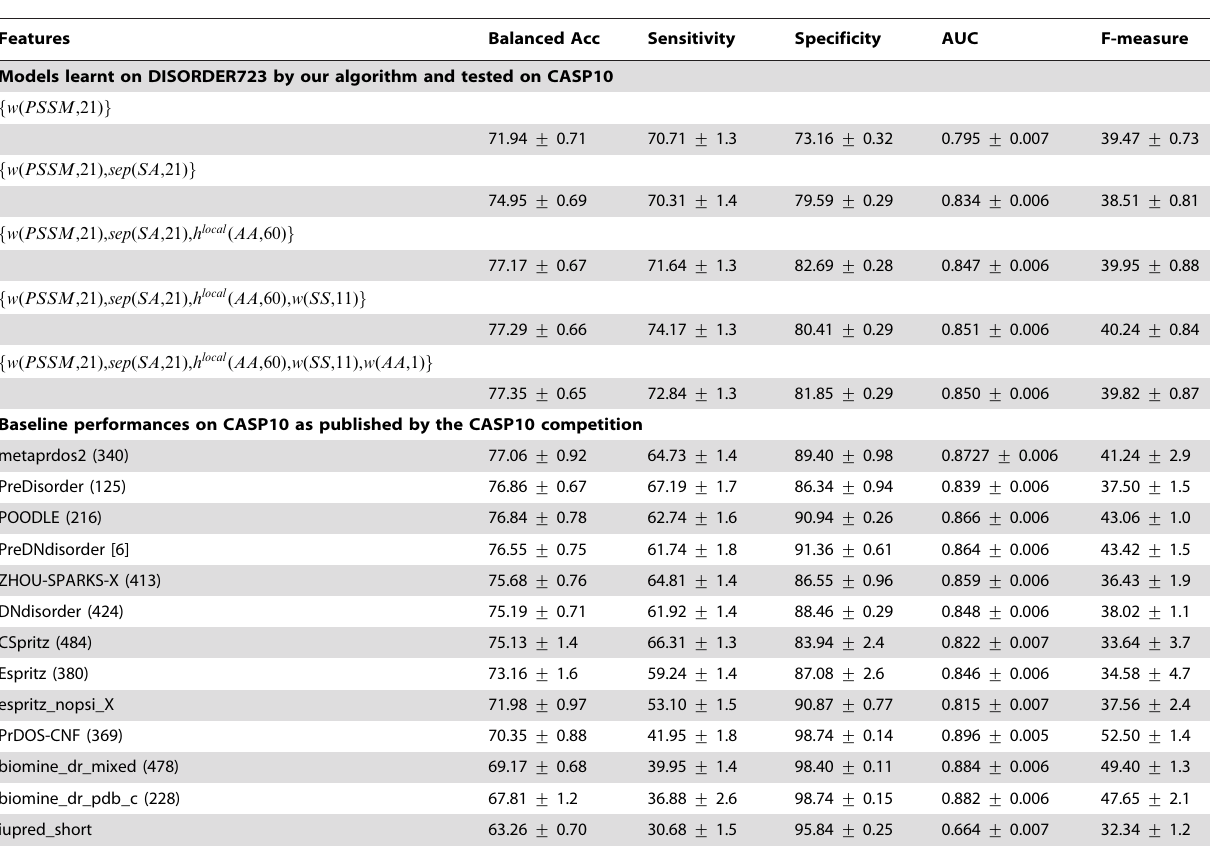
Table 6. Accuracy evaluation on the CASP10 dataset.